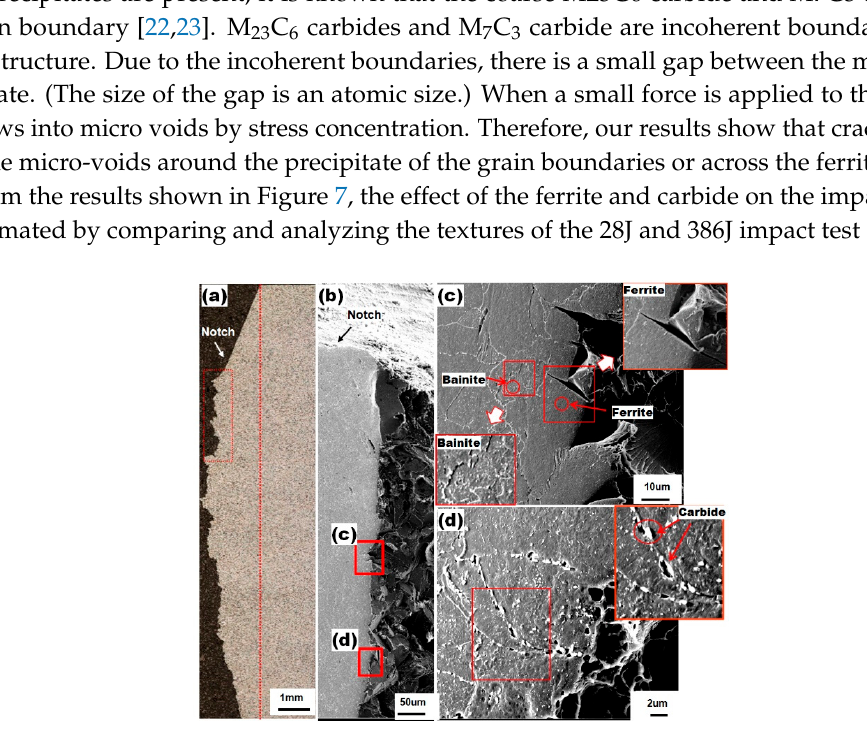
Figure 7. Microstructure of the 28J specimen cross-section. ( a ) OM image; ( b ) SEM image; ( c , d ) SEM image of regions enlarged by the red squares in ( b